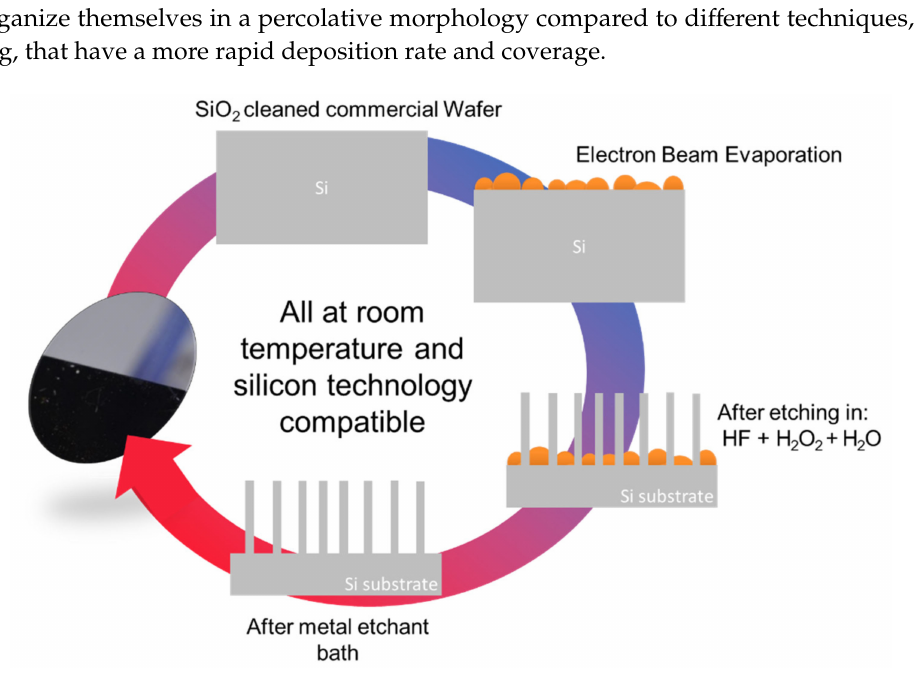
Figure 1. Scheme of the thin metal film Metal-Assisted Chemical Etching for the realization of silicon nanowires (Si